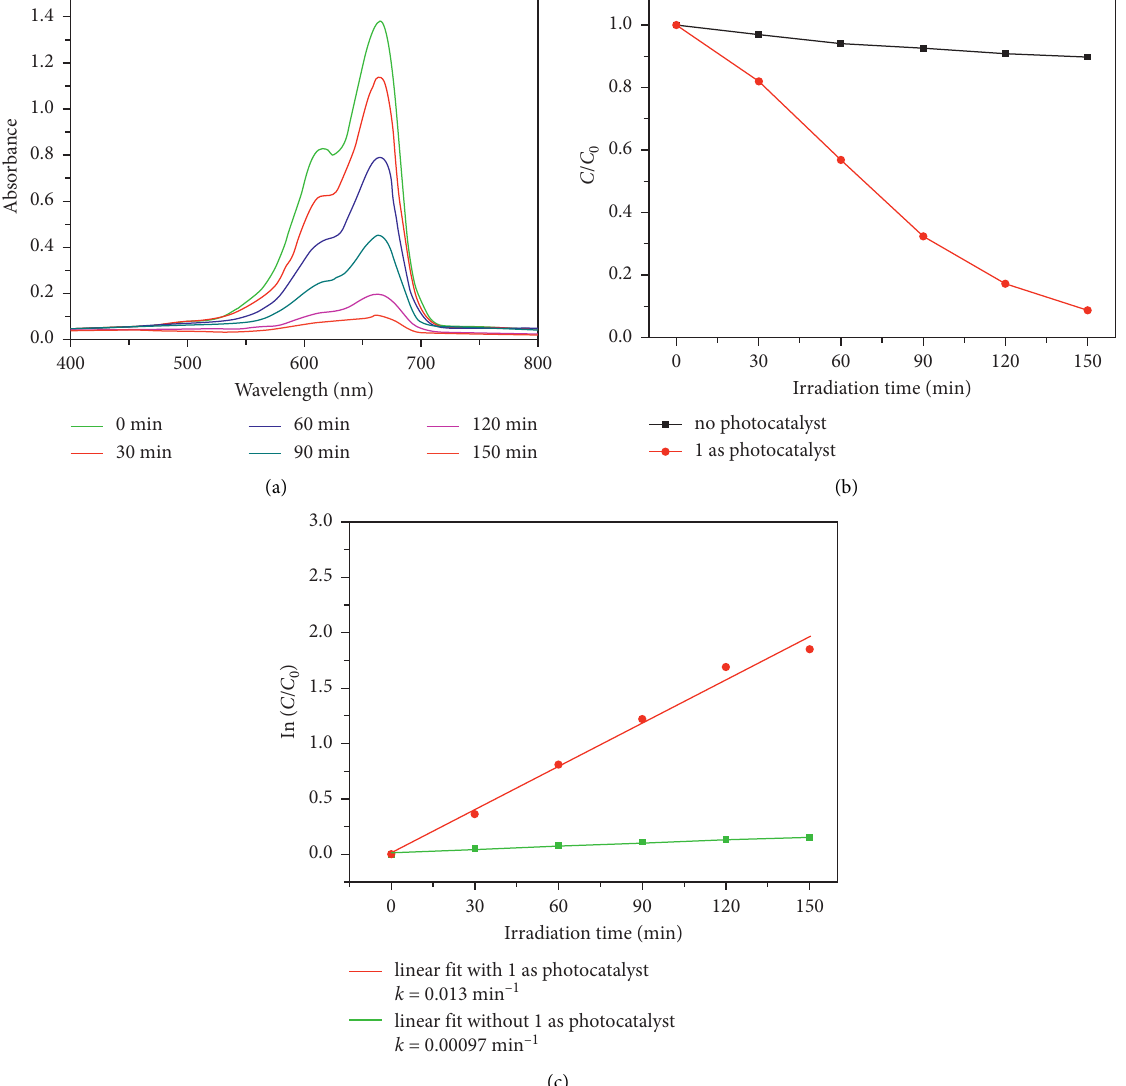
Figure 3: (a) UV-visible absorption spectrum of MB in the presence of 1 under ultraviolet light. (b) curve of C/C0 with irradiation time with and without photocatalyst 1. (c) First kinetics of photodegradation of MB under UV light with and without photocatalyst 1 .